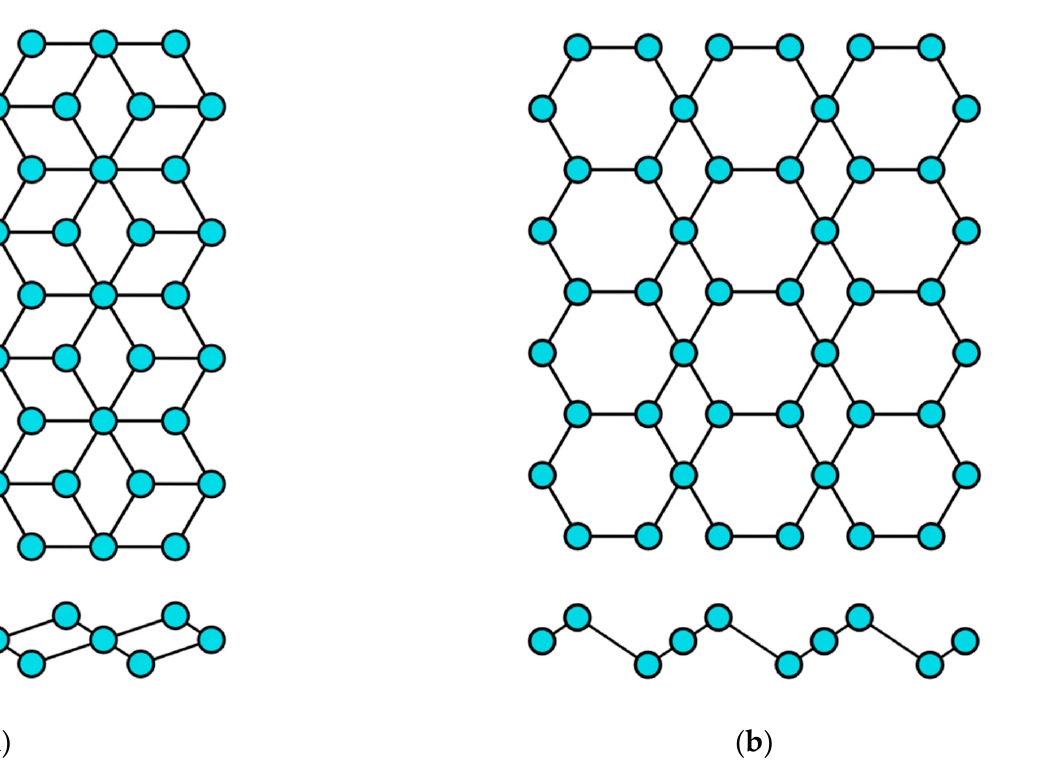
Figure 5. Two variants of the crystal structure of selenene and tellurene: ( a ) α -phase and ( b ) β -phase. According to the theoretical calculations, the distance between atoms in selenene should be l ≈ 0.27 nm [88]. The two-dimensional tellurium layer (tellurene) has the same crystal structure modifications as selenene (Figure 5), and its lattice parameter l is about 0.3 nm [88–90] (Table 4). Table 4. Parameters of the honeycomb lattice of group VIA